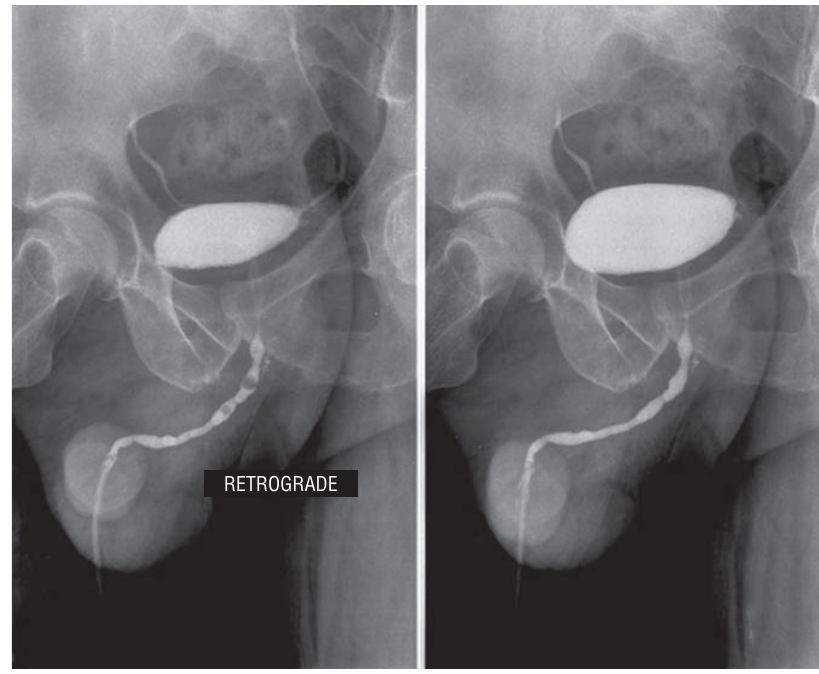
Figure 3 - Panurethral stenosis. Retrograde urethrography.